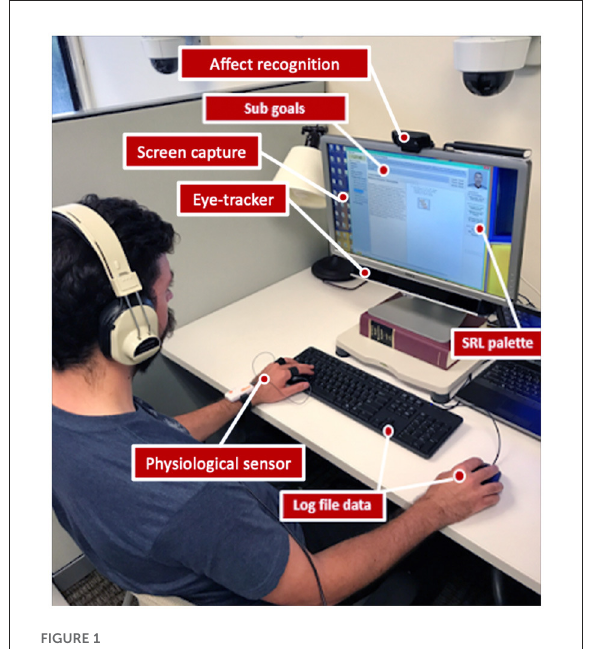
FIGURE1 Experimental set-up to collect multimodal SRL data with